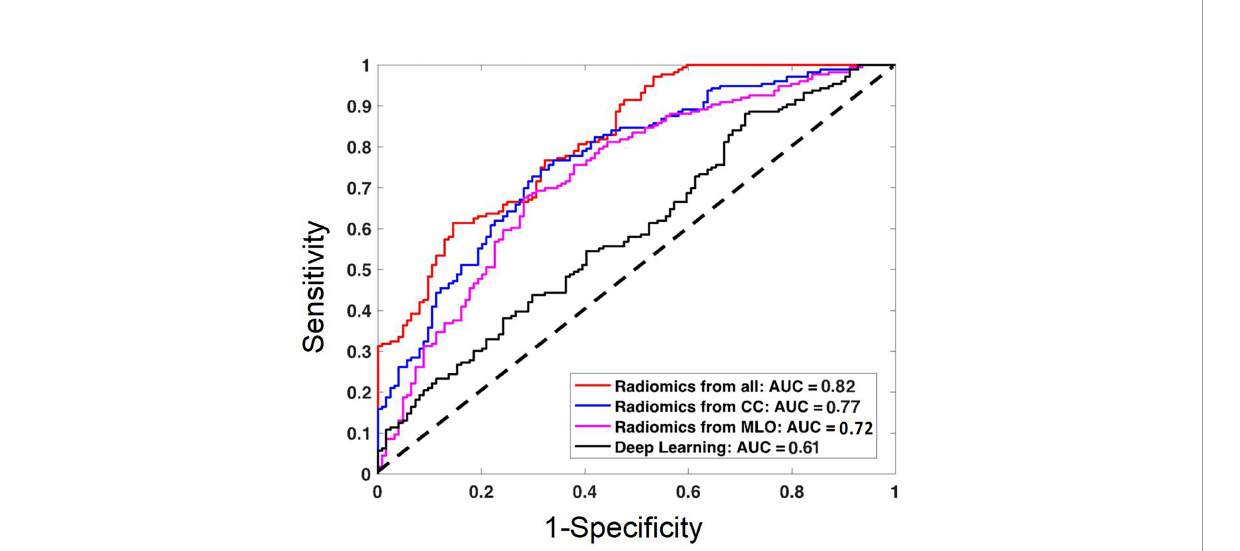
FIGURE 4 The ROC curves constructed by using the radiomics scores obtained from the models built using the combined CC and MLO features, CC features only, MLO features only; and the ROC curve constructed by using the probability obtained from the deep learning model. The AUC of the combined radiomics model is the highest, 0.82. The AUC of the deep learning model is the lowest, 0.61, likely due to the use of the whole image as the